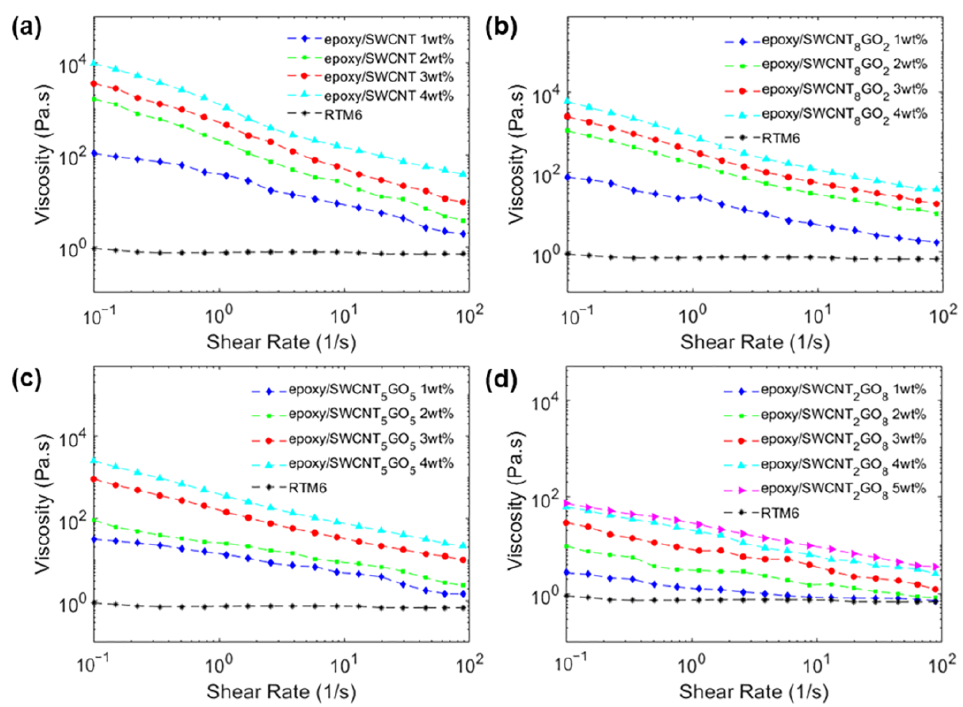
Figure 5. Viscosity of ( a ) epoxy/SWCNT, ( b ) epoxy/GNP 2 SWCNT 8 , ( c ) epoxy/GNP 5 SWCNT 5 and ( d ) epoxy/GNP 8 SWCNT 2 mixtures as a function of shear rate measured at the temperature of 80 °C.